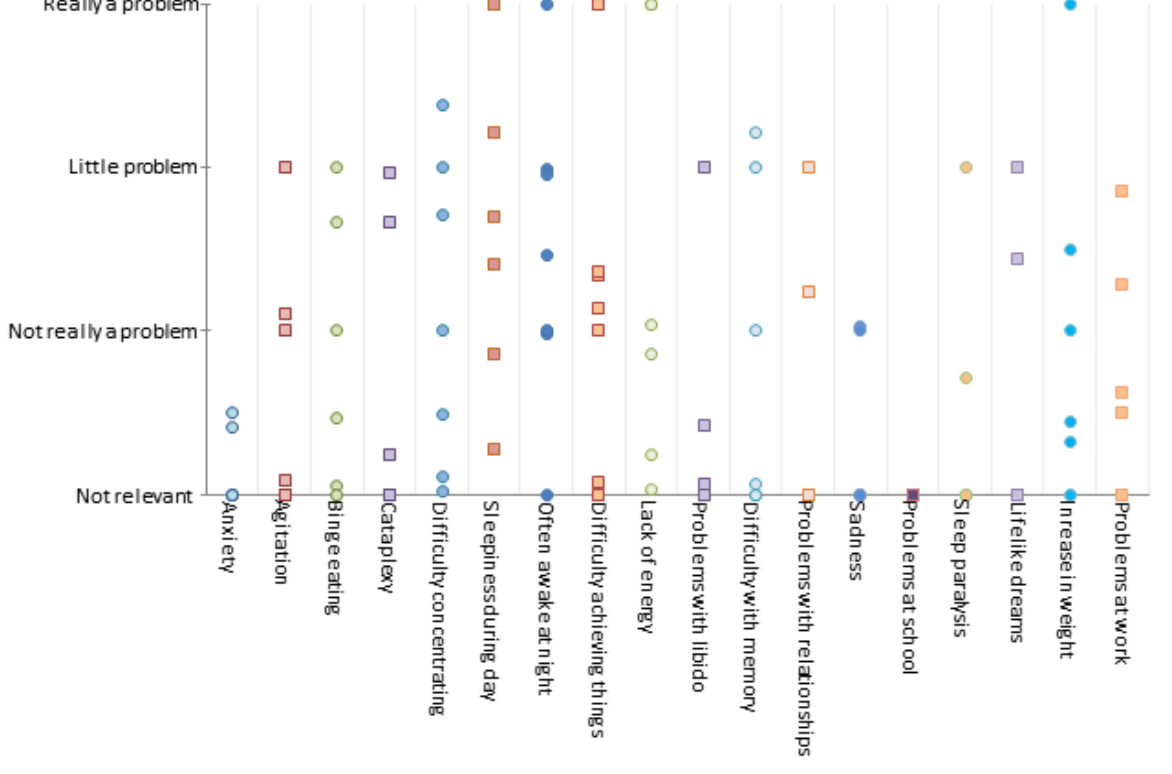
Figure 6. Mean score per patient per symptom. Patients provided input on all 18 symptoms. Bullet points may capture the input of more than 1 patient, especially on the “not relevant” and “really a problem”